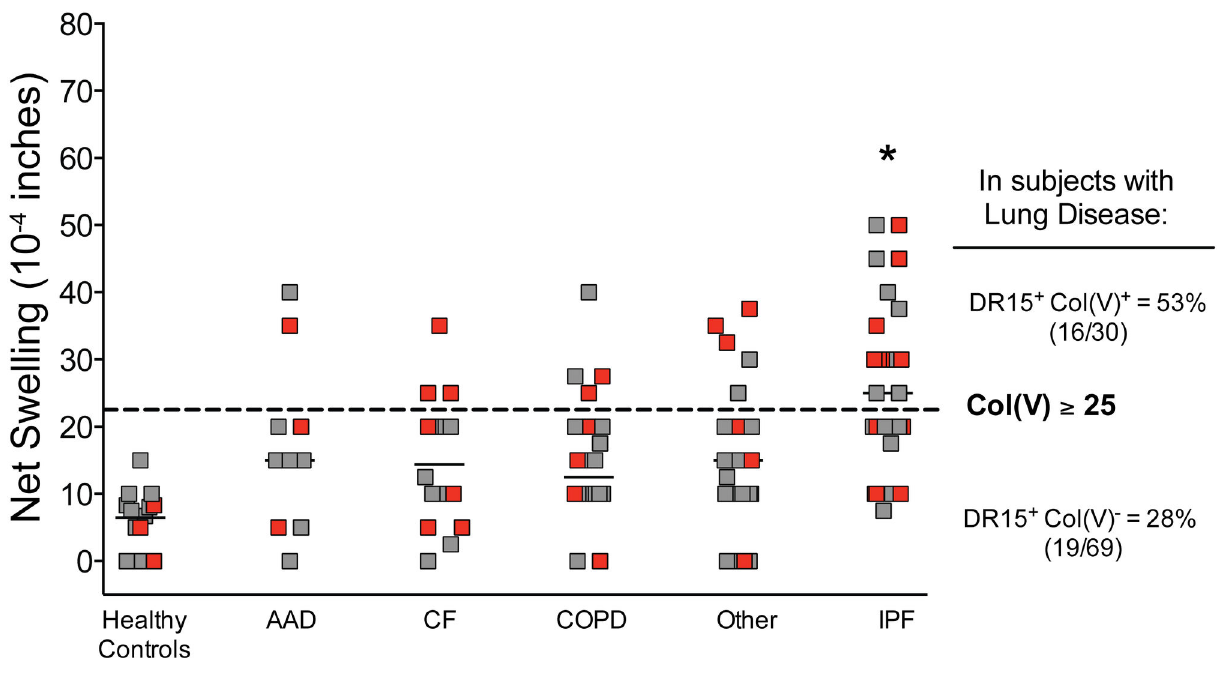
Figure 1. Differences in TV-DTH reactivity pre-transplant to col(V) in patients with end-stage lung disease by disease type and by prevalence of DRB1*1501. A significant number of patients with IPF had col(V) reactivity (net swelling ≥ 25 x 10 -4 inches, dotted line; *ANOVA p<0.0007). Independently, patients with DRB1*1501 (red symbols) were enriched in col(V) responders (net swelling ≥ 25 x10 -4 inches, Chi Square p= 0.01). AAD - α1 -antitrypsin disease; CF - cystic fibrosis; COPD - chronic obstructive pulmonary disease; IPF - idiopathic pulmonary fibrosis. Patients with lung diseases: n=53 (previous publication, [14]), n=45 new subjects, and n=1 subject who donated samples to both studies (average values of 2 time-points). Healthy subjects (n=14) with known HLA-DR types were tested and used as controls. doi: